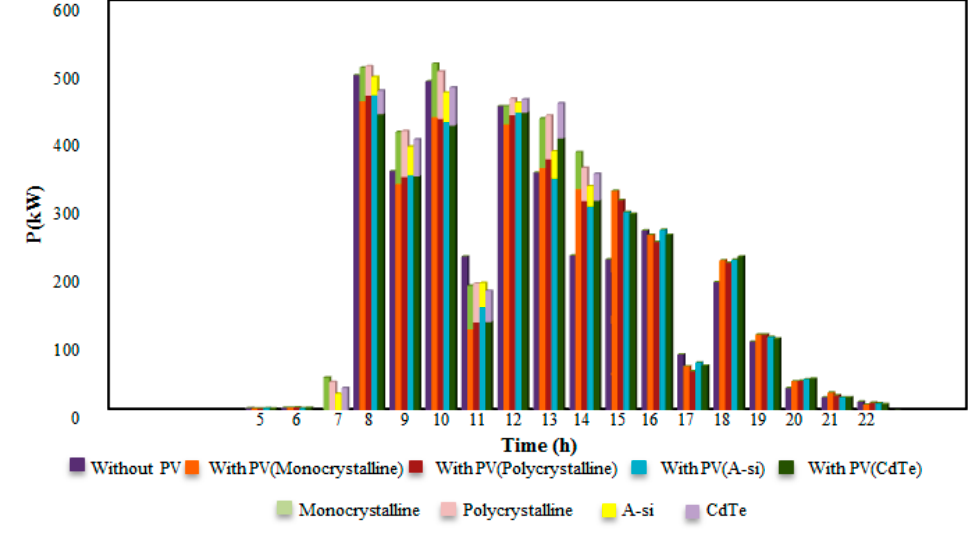
Figure 7. Power supplied by DSO and PV panel in August.